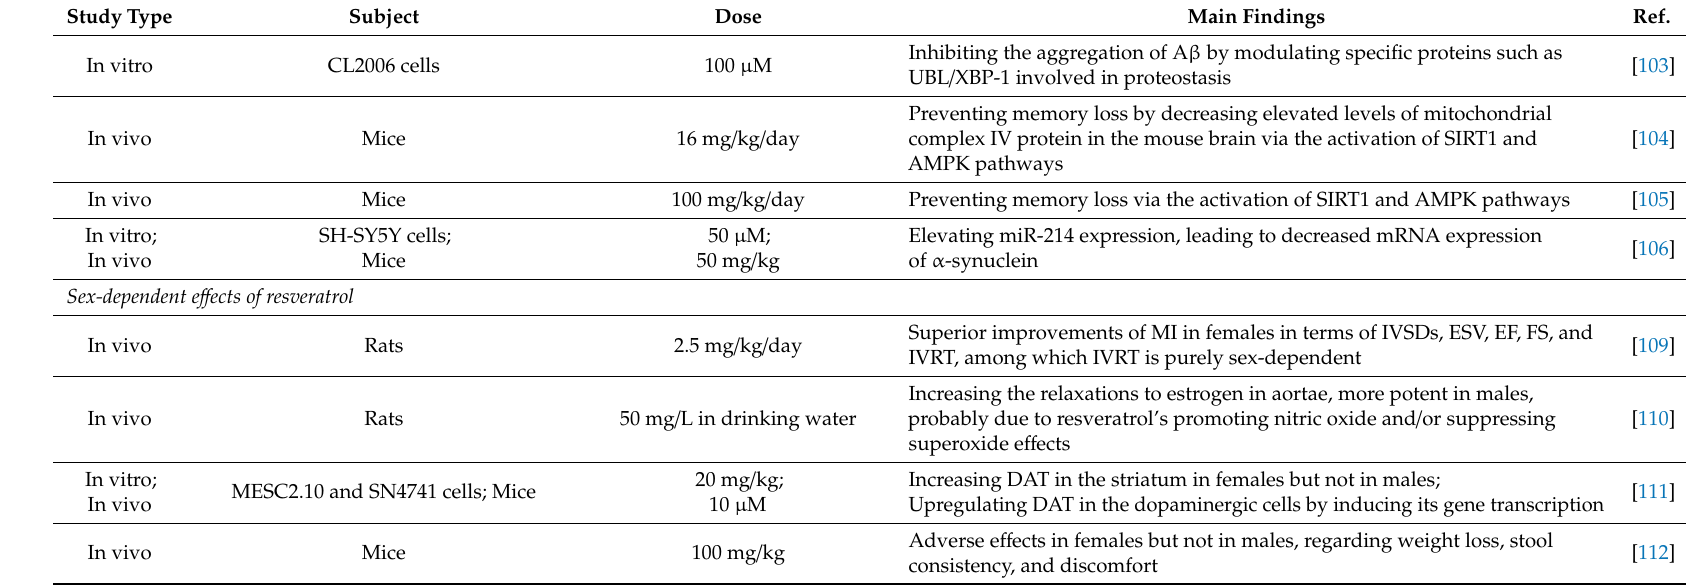
Abbreviations used in the table: AC, acetyl; AhR, aryl hydrocarbon receptor; Akt, protein Kinase B; AMPK, AMP-activated protein kinase; A β , amyloid β ; cAMP, cyclic adenosine monophosphate; CAT, catalase; cGMP, cyclic guanosine monophosphate; CHOP, C / EBP homologous protein; COX-2, cyclooxygenase-2; DAG, diacylglycerol; DAT, dopamine